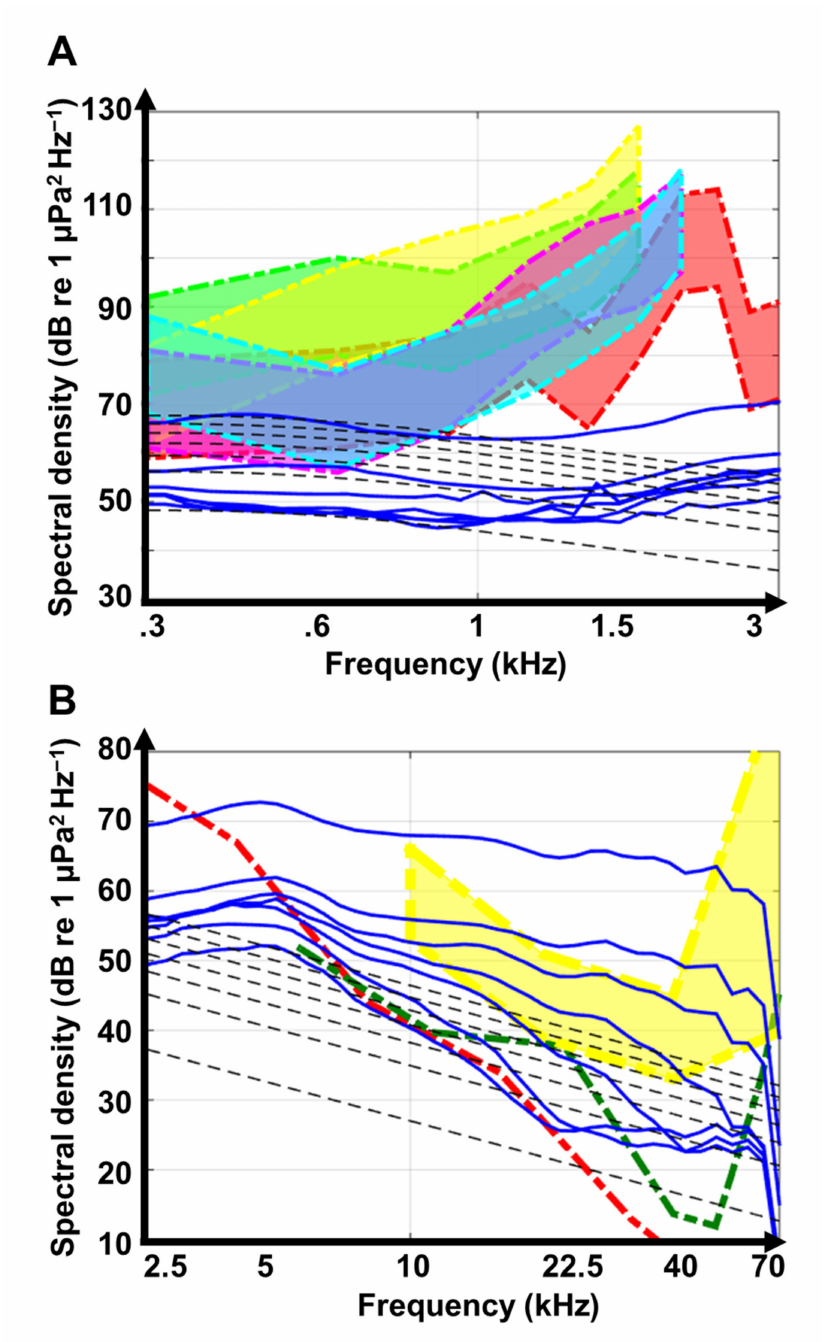
Figure 7. Audiograms of ( A ) fish post-larvae and ( B ) cetaceans compared to spectrum level of ambient noise level (ANL) at different distances from the barrier reef. Solid blue line: measured ANL on one of the six transects; from top to bottom: at 138, 476, 964, 2134, 3896, 6831, 9866 m from the reef crest. Dashed black line: Wenz’s ambient noise curves; from bottom to top: 0, 3, 6, 9, 12, 15 and 18 kn of wind. Equivalent threshold (for details of the transformations, see Table S3). ( A ) Red: Myripristis kuntee , green: Abudefduf vaigiensis , yellow: Acanthurus triostegus , magenta: Chaetodon citrinellus and cyan: Rhinecanthus aculeatus ; ( B ) Red: Stenella coeruleoalba , green: Mesoplodon densirostris and yellow: Globicephala macrorhynchus